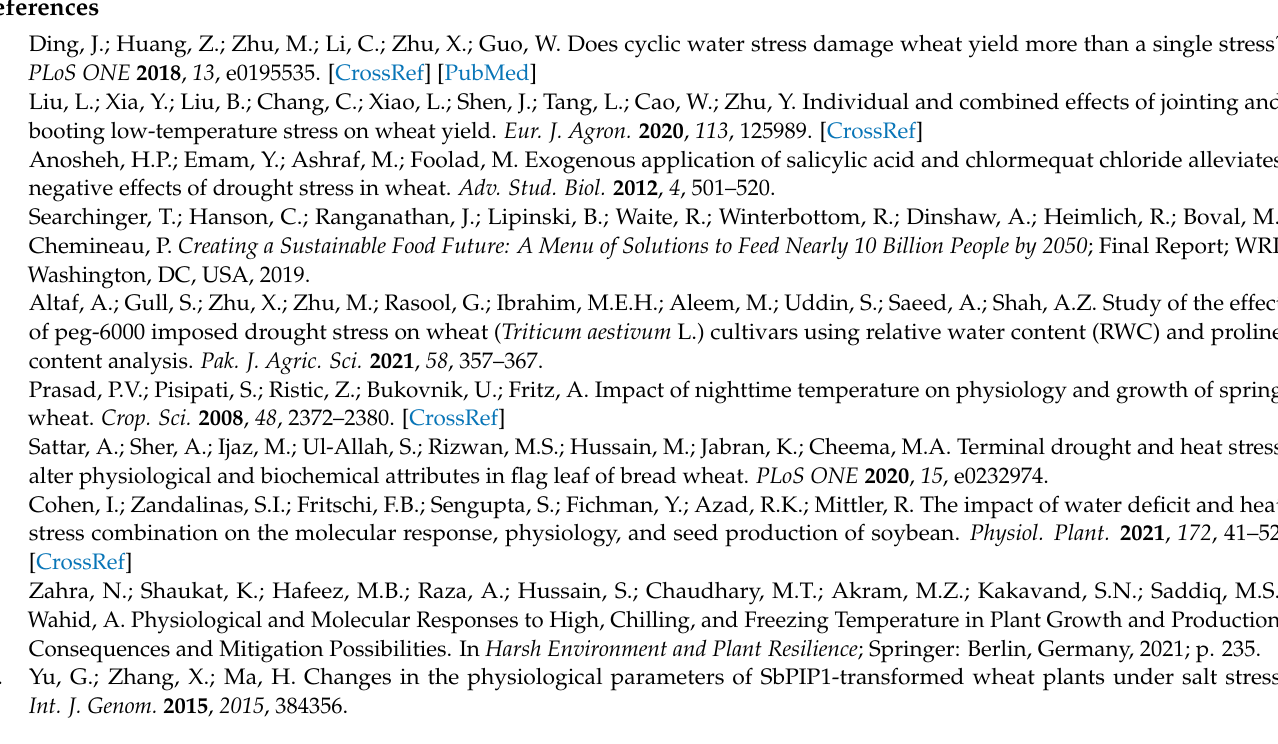
(b), and heat stress (c) experiments. Figure S2. Schematic representation of the experimental design. Figure S3. Time bar graph of the whole study. Table S1. Photosynthetic attributes of the wheat plant. Table S2. Properties of the soil used in the